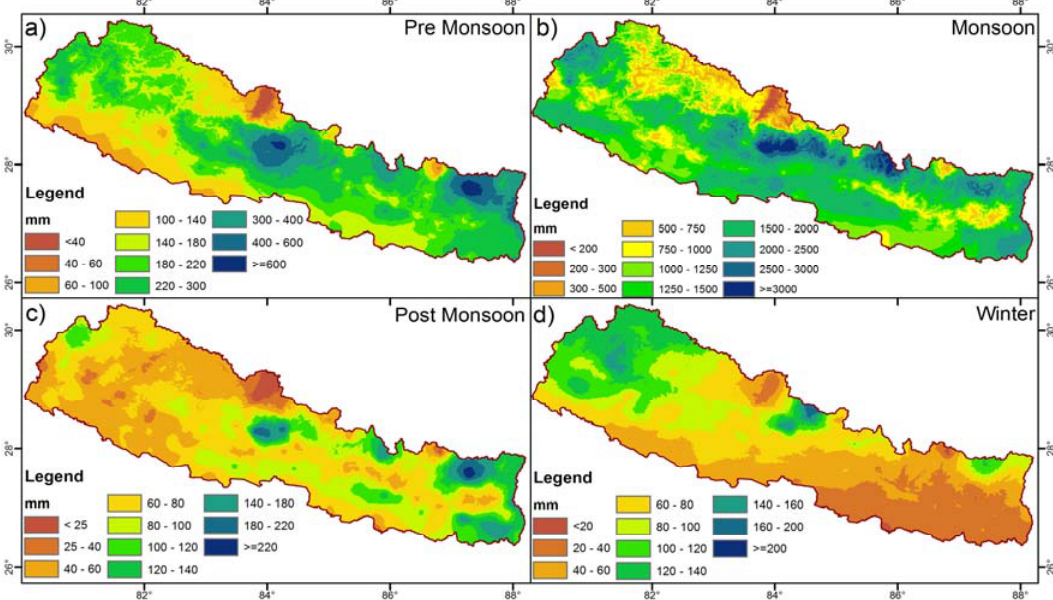
Figure 3. Spatial distribution of mean seasonal precipitation (mm) for ( a ) Pre monsoon; ( b ) Monsoon; ( c ) Post monsoon; and ( d ) winter season over the period of 1981–2010. Note: Legend scale of all four seasonal maps are different.